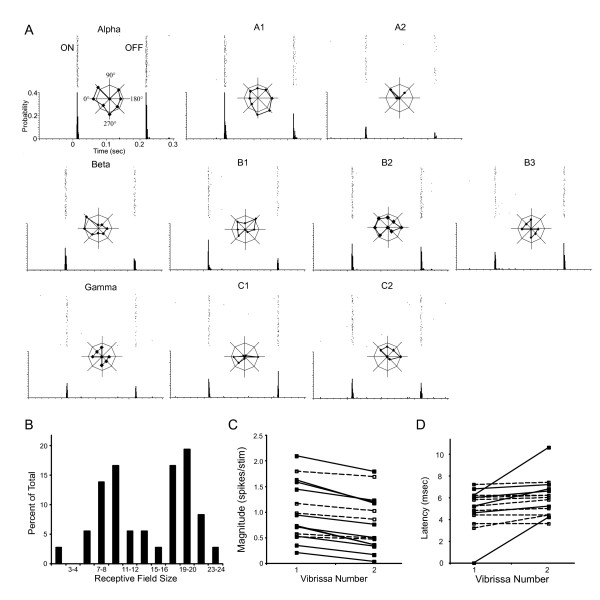
Superior colliculus neurons have large receptive fields with principal whiskers. A: An example of a neuron with a 17-vibrissa receptive field. Responses to individual deflections of 10 vibrissae with the piezoelectric device are depicted, with the vibrissa deflected indicated above each PSTH. Vibrissae were deflected in eight different directions (0° is caudal, 90° is dorsal), and ON responses to each direction were used to create the polar tuning curves. Distance from the center of the polar tuning curve represents the magnitude of the response for deflections in that direction. The radii of the octagons represent one spike/stimulus. The PSTHs were constructed by pooling spikes recorded in response to each of the eight directions. B: Histogram of receptive field sizes of collicular neurons, defined as the number of vibrissae evoking responses to manual stimulation. C: Difference in response magnitude to stimulation of different vibrissae. For each neuron, vibrissae were ordered according to their response magnitudes ("V1" evoked the largest magnitude response, "V2" the second largest magnitude, etc). Eleven of 16 neurons showed a significant difference in magnitude between V1 and V2 (solid lines, paired t-test, P < 0.005). D: Difference in onset latency to stimulation of different vibrissae. For each neuron, vibrissae were ordered according to their response latency ("V1" evoked responses at the shortest latency, etc). Six of 16 neurons showed a significant difference in latency between V1 and V2 (solid lines, paired t-test, P < 0.005).